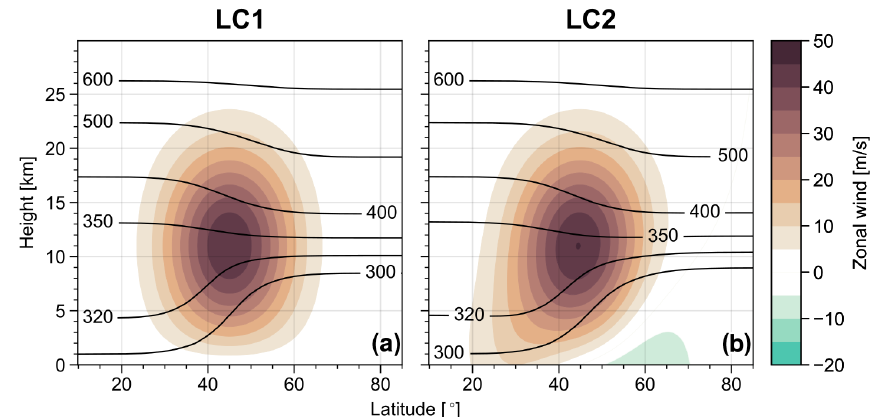
Figure 1. Zonal mean zonal wind (shading) and potential temperature (contours, in K) for (a) LC1 and (b) LC2 initial conditions.